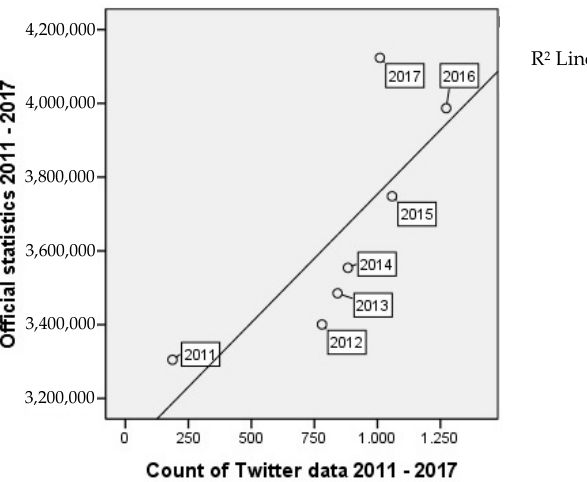
Figure 13. Scatter plot of official tourism and Twitter data distribution for the period 2011–2017. The x-axis denotes the absolute number of twitter data twitter data and the y-axis the absolute number of arrivals from the official statistics. R 2 is the coefficient of determination of the regression line.